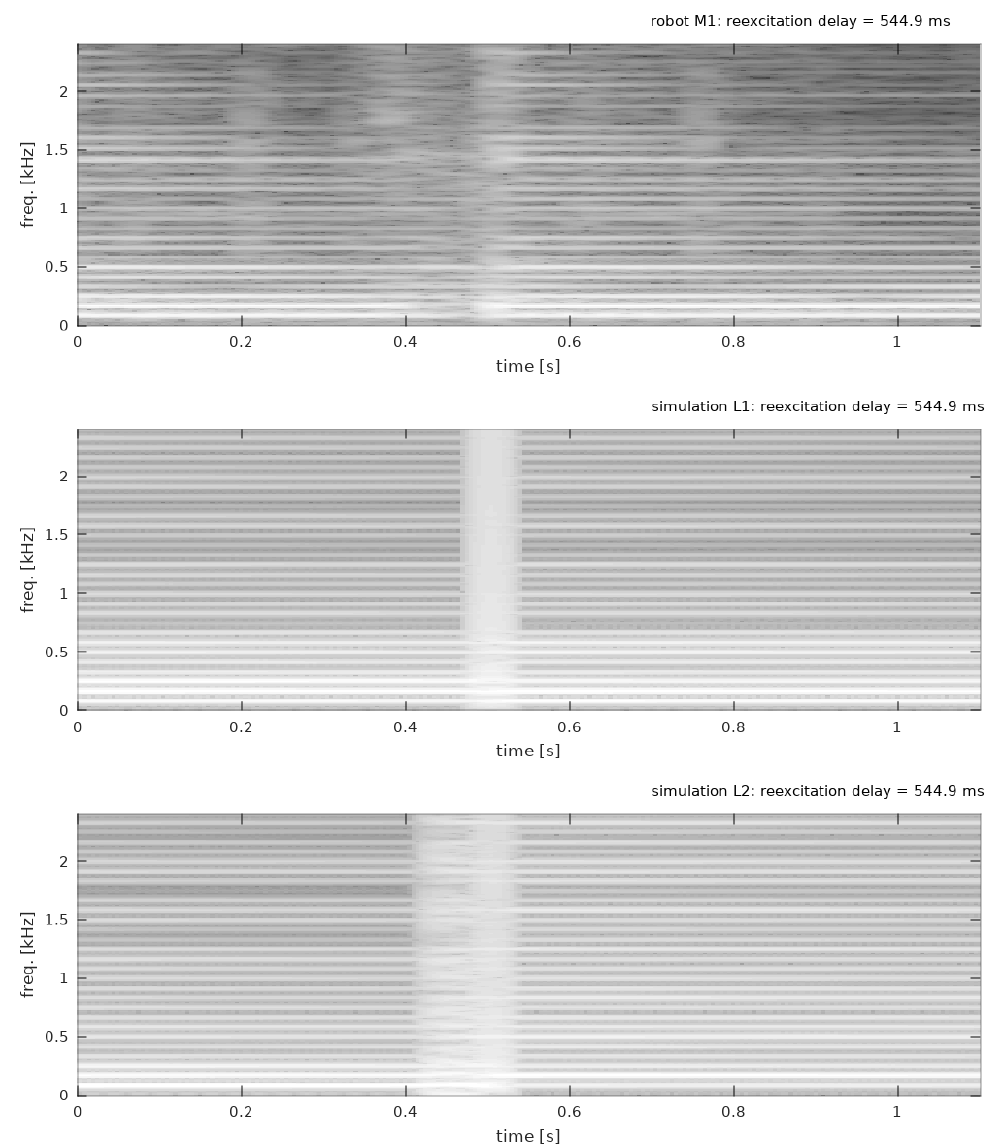
Figure 12. Spectrograms of slow re-excitation for robot measurements ( top ) and both simulations ( middle and bottom